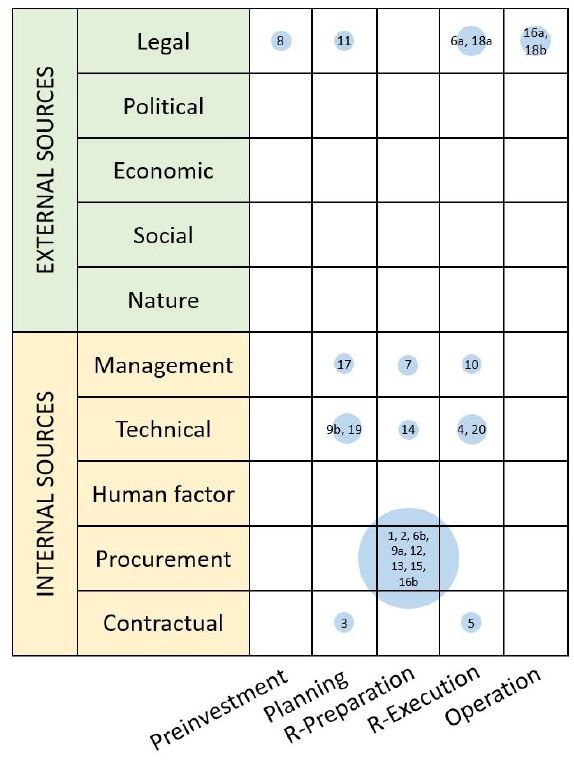
Figure 1: Two-dimensional risk cause breakdown structure